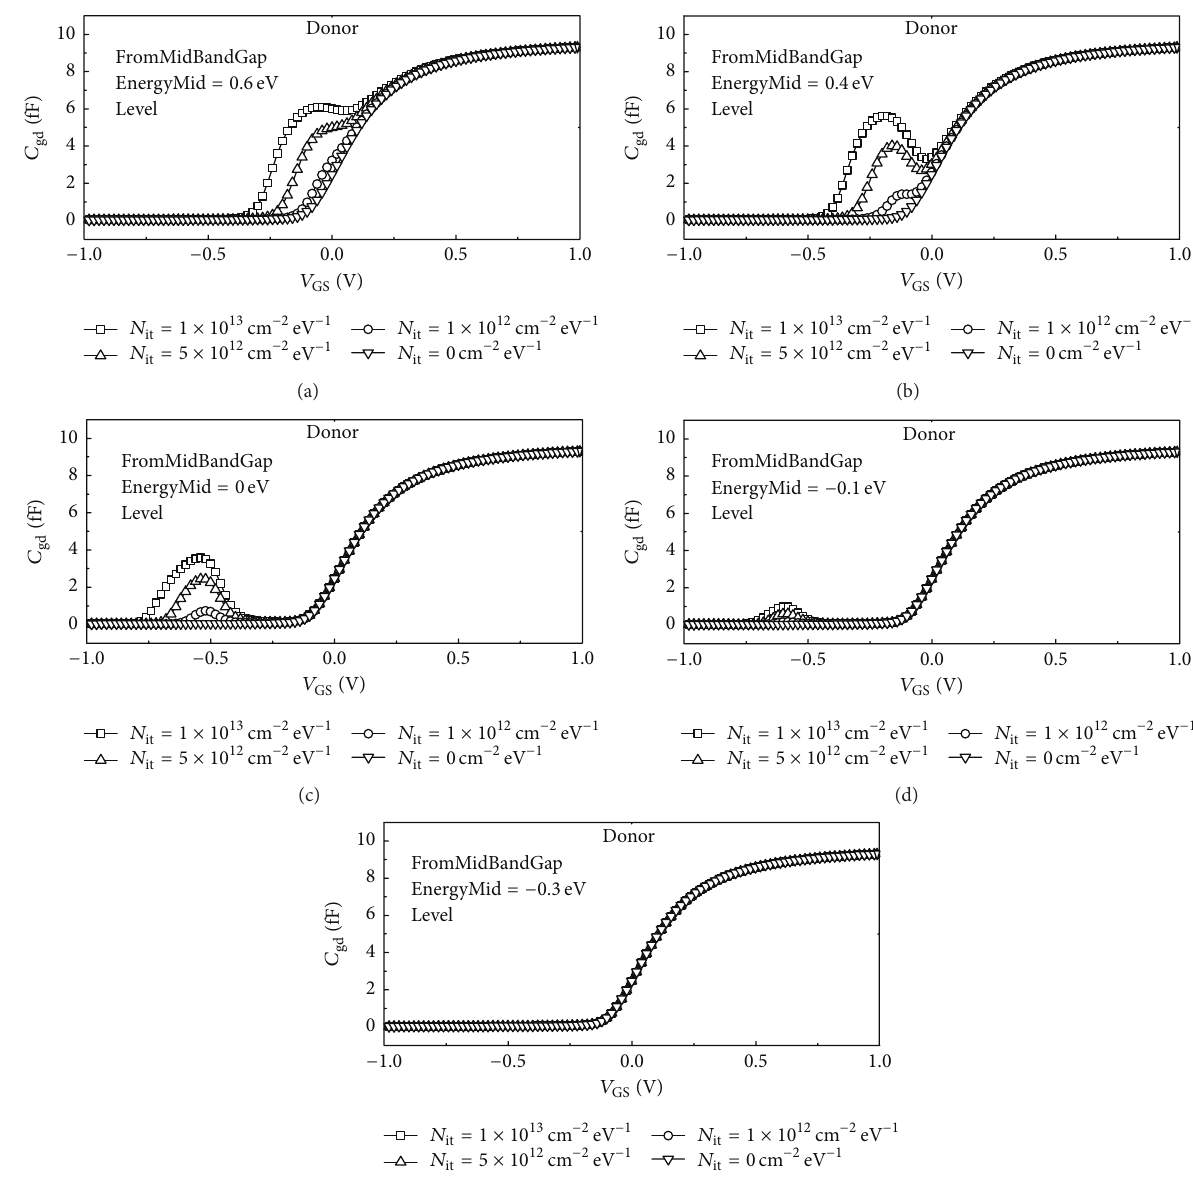
= 0.5 V with variable ITs density 𝑁 . (a) The trap is DS it